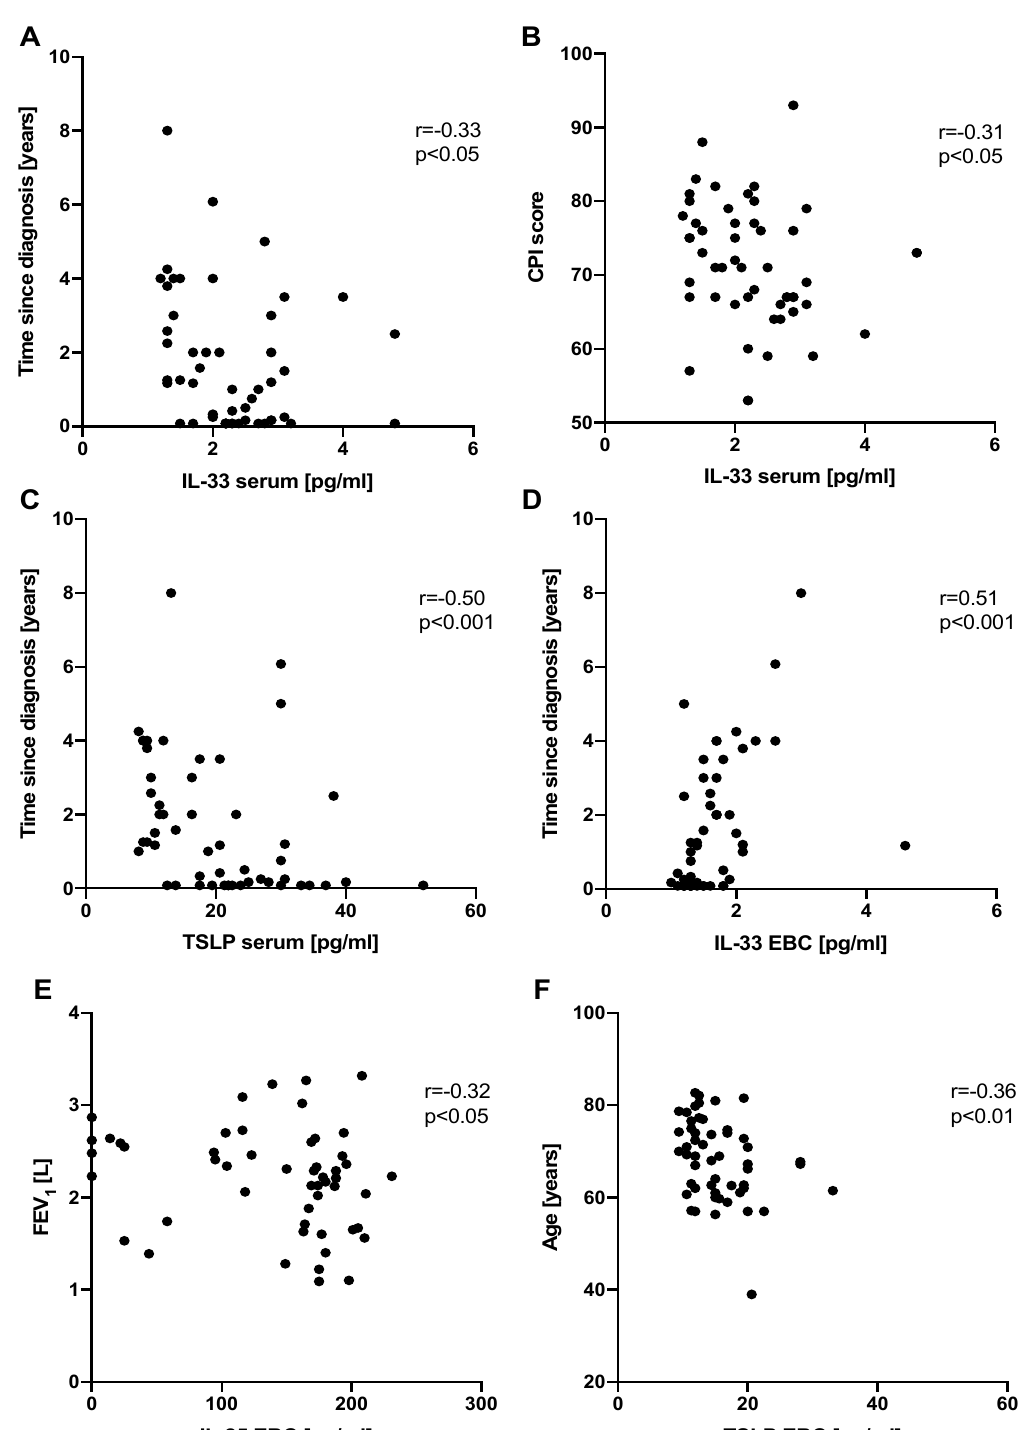
Figure 4. Graphical presentation of significant correlations between the epithelial alarmin levels and clinical measures in patients with IPF. Notes: Panels showing correlation between: ( A ) IL-33 serum levels and time since diagnosis, ( B ) IL-33 serum levels and CPI score, ( C ) TSLP serum levels and time since diagnosis, ( D ) IL-33 EBC levels and time since diagnosis, ( E ) IL-25 EBC levels and FEV 1 , ( F ) TSLP EBC levels and age. IPF—idiopathic pulmonary fibrosis, EBC—exhaled breath condensate, IL-25—interleukin 25, IL-33—interleukin 33, TSLP—thymic stromal lymphopoietin, FEV 1 —forced expiratory volume in 1 second, CPI—composite physiologic